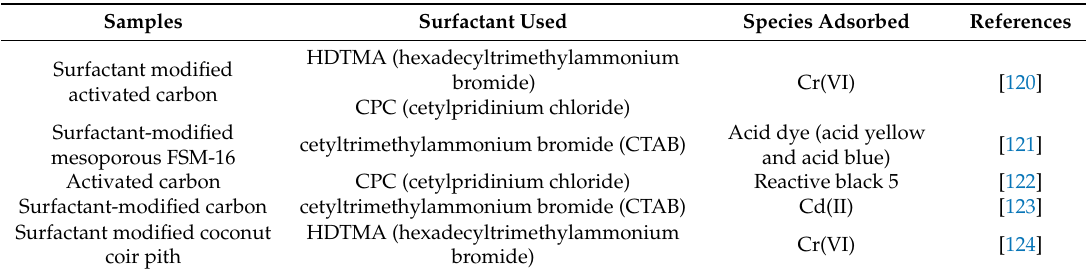
Table 5. Surfactant-modified carbons to adsorb contaminants from aqueous media.